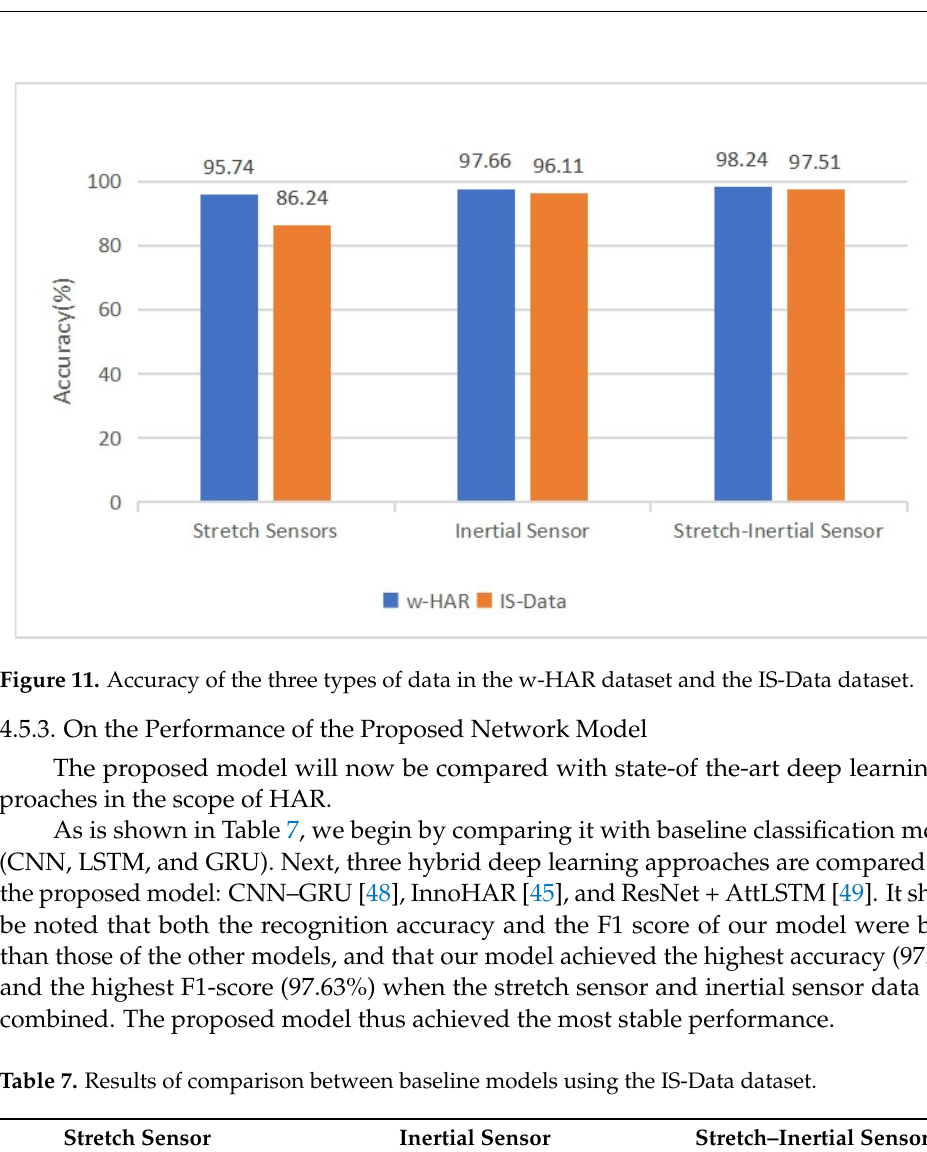
Table 7. Results of comparison between baseline models using the IS-Data dataset.